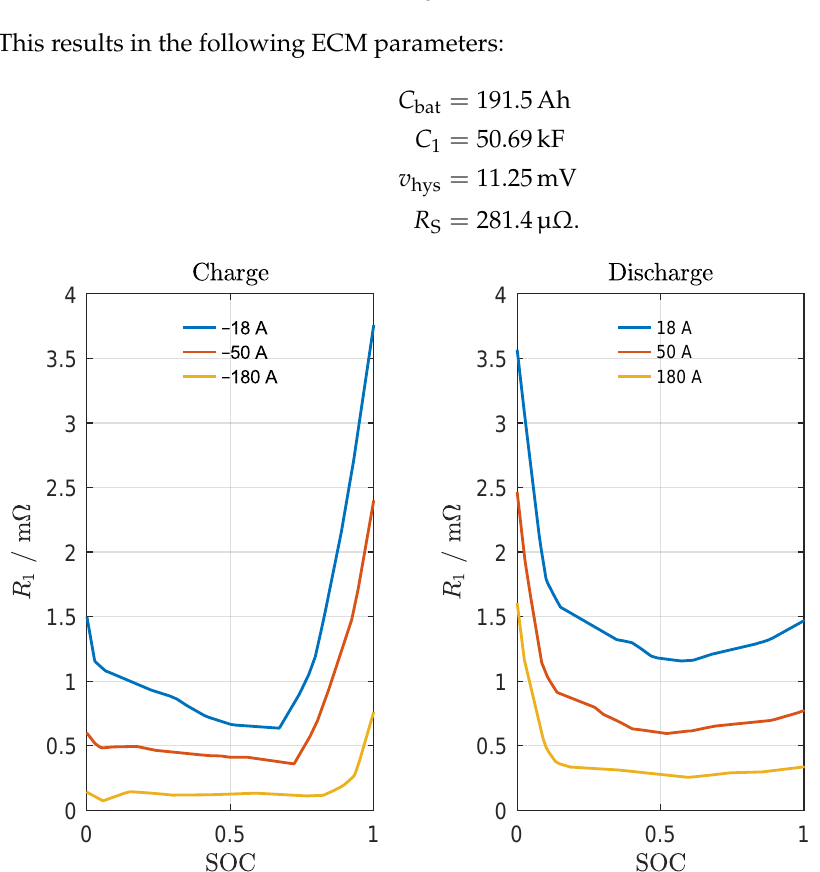
Figure 6. Simulation results: approximation results for R 1 as a function of SOC for different battery currents; ( left ): charging, ( right ):